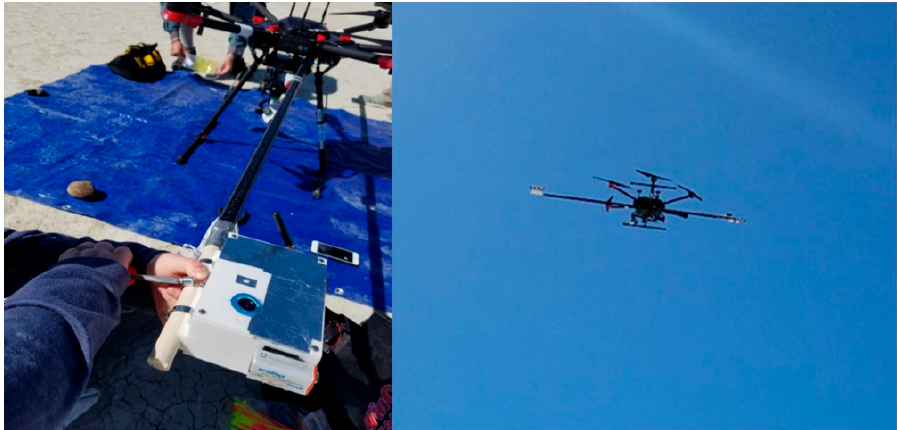
Figure 8. Configuration of instrument mounted to unmanned aircraft system (UAS). A long pole, approximately 2 m in length, was used to extend the instrument away from the body of the aircraft. This was done to limit the effects of the aircraft on albedo measurements, specifically those that would change the surrounding radiation field.